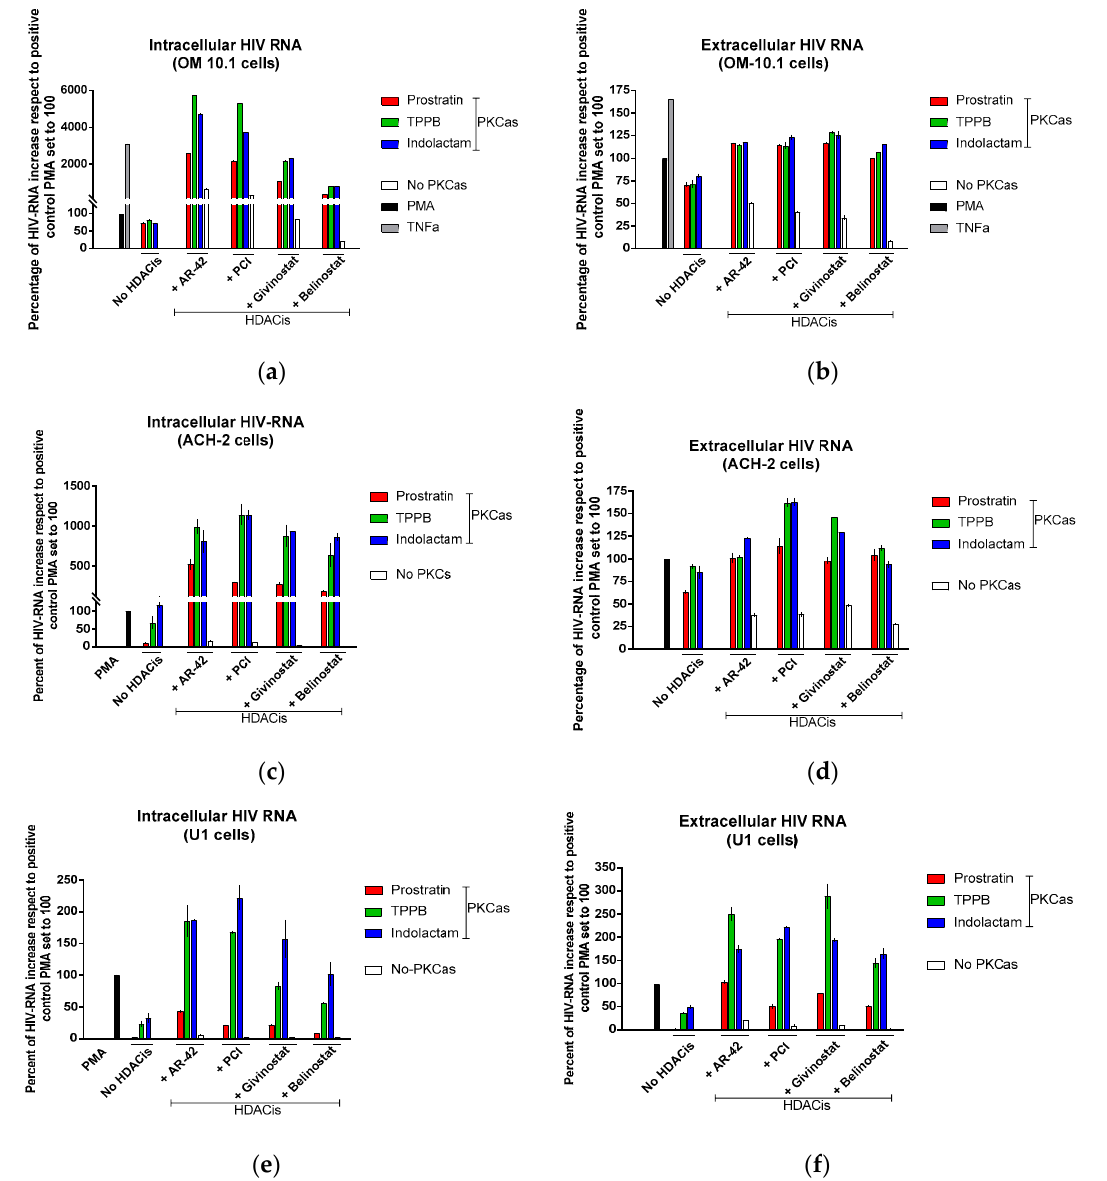
Figure 4. Combinations of LRAs reactivate latent HIV measured using HIV RNA quantification. ( a , b ) OM-10.1, ( c , d ) ACH-2, and ( e , f ) U1 cells were treated with LRAs alone or in combination for 48 h. OM-10.1 positive control cells were treated with PMA or TNF α . U1 and ACH-2 positive control cells were treated with PMA. The cell-associated (intracellular) and virus-associated (extracellular) HIV RNA was detected using qRT-PCR and expressed as a percentage of the positive control PMA set to 100 (black columns). Gray columns represent cells treated with TNF α ; red columns are cells treated with prostratin in combination with or without HDACis; green columns are cells treated with TPPB in combination with or without HDACis; blue columns are cells treated with indolactam in combination with or without HDACis; and white columns are cells treated with a single HDACi. Data are shown as mean ± S.D. of three independent experiments.